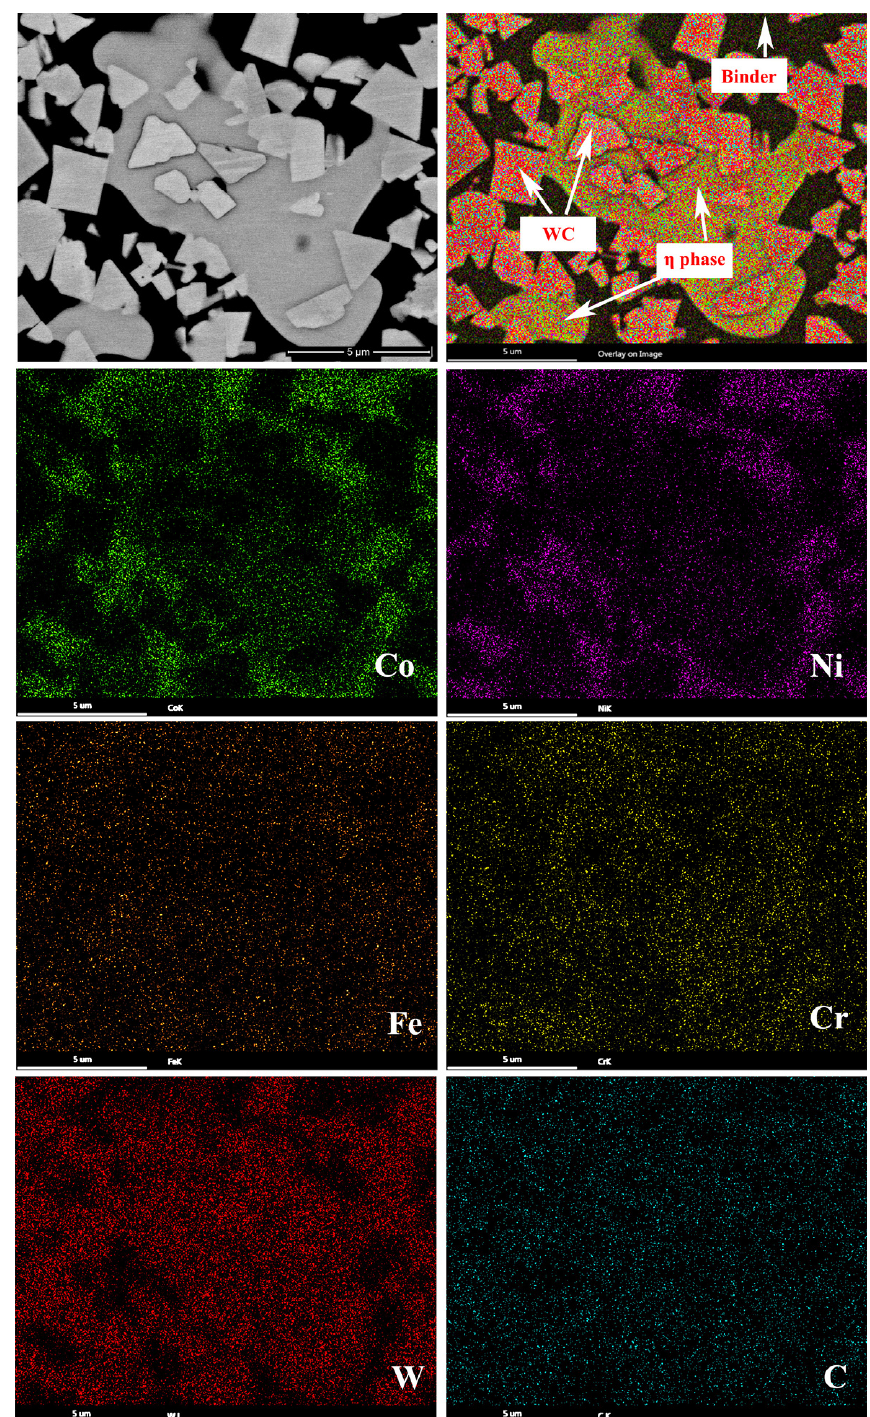
Figure 3. Characteristic elemental EDS ‐ SEM mapping of Alloy 1.